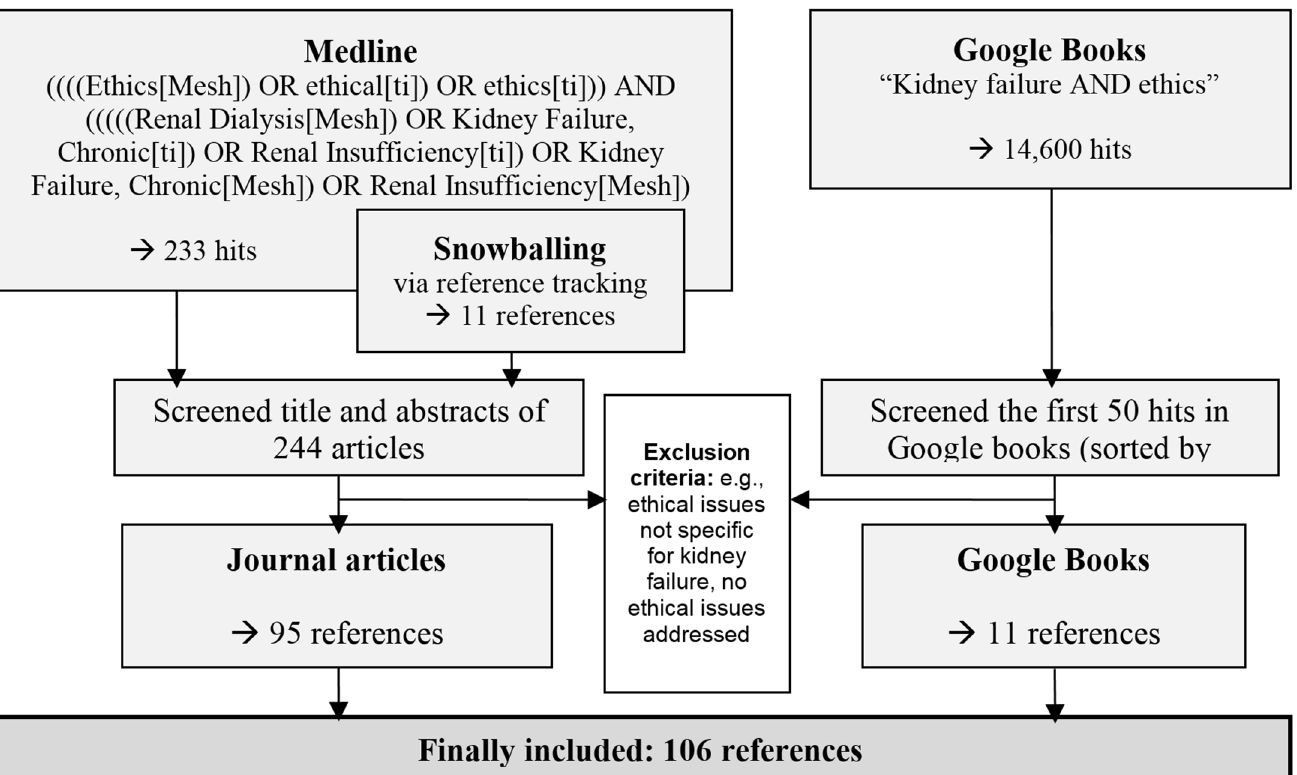
Fig 1. Flow diagram for inclusion/exclusion of